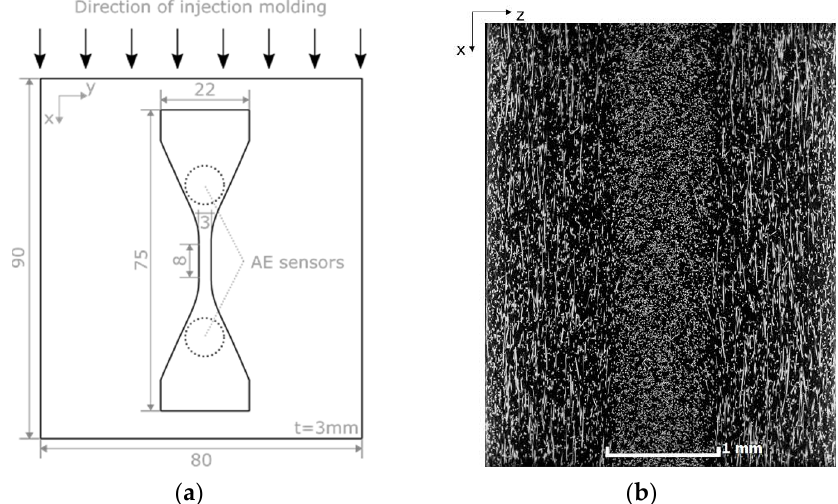
Figure 1. ( a ) Optimized specimen geometry with schematic position of AE sensors, dimensions in mm; ( b ) exemplary cross section within the gauge length resolved from an X-ray scan with a resolution of 2.0 µm. Direction of injection mold- ing is along the x